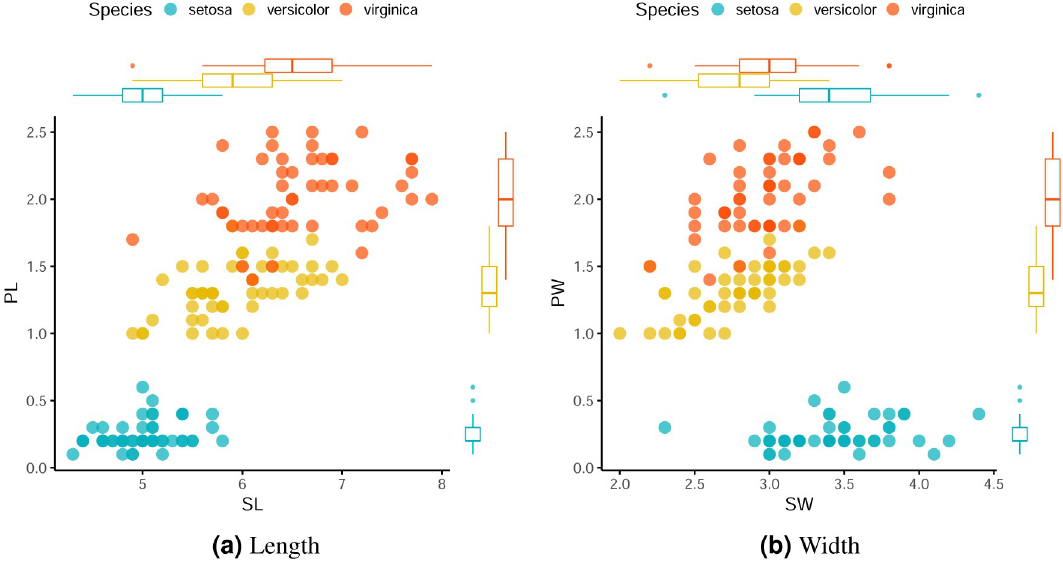
Fig 2. Scatter plots and boxplots for the Iris Plant dataset. ( a ) Length. ( b )